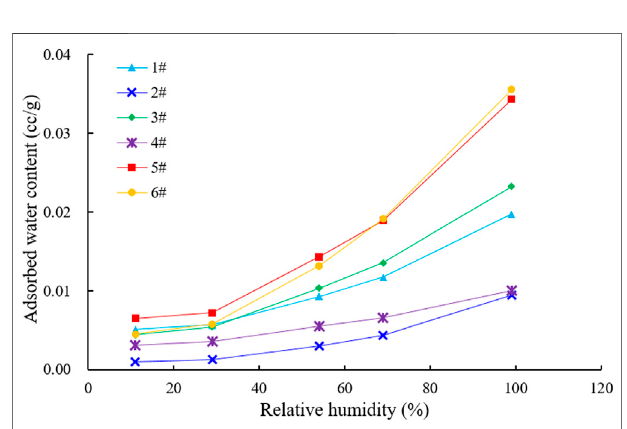
FIGURE 2 | Equilibrium moisture adsorption curves of different shale